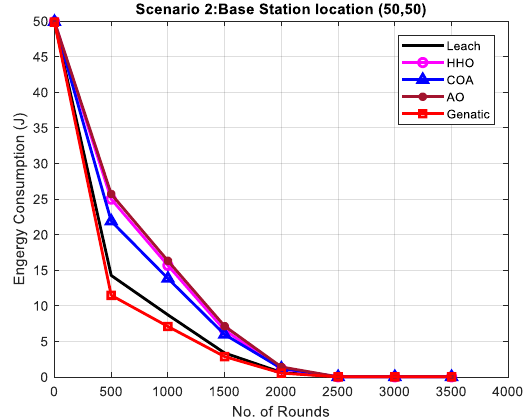
Figure 7. Energy consumption in case of scenario 2: BS at (50,50).